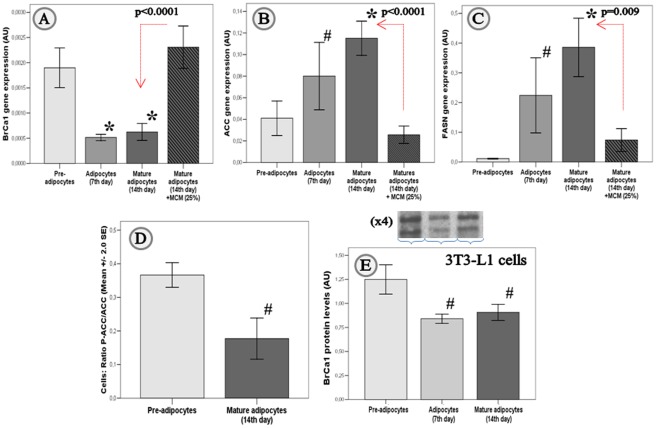

BrCa1 in cultured adipocytes.
Real Time-PCR: Mean ±2.0 SE of gene expression levels for BrCa1 (Fig. 2a), ACC (Fig. 2b), and FASN (Fig. 2c) during adipogenesis of human fat cells at days 0, 7th and 14th (n = 3/day) after inducing differentiation, and in mature adipocytes after 48 h treatment of macrophage conditioned medium (+MCM; 25%). ELISA: Mean ±2.0 SE for phosphorylated ACC normalized versus ACC total (ratio P-ACC/ACC) after in vitro differentiation (Fig. 2d) of human pre-adipocytes to mature adipocytes (n = 3/day). Western-blot: Mean ±2.0 SE of protein levels for BrCa1 during differentiation of 3T3-L1 (Fig. 2e; n = 4/day). * p<0.0001 and # p<0.05 for comparisons between levels assessed in adipocytes at 7th and/or 14th day after inducing differentiation in vitro, and pre-adipocytes.